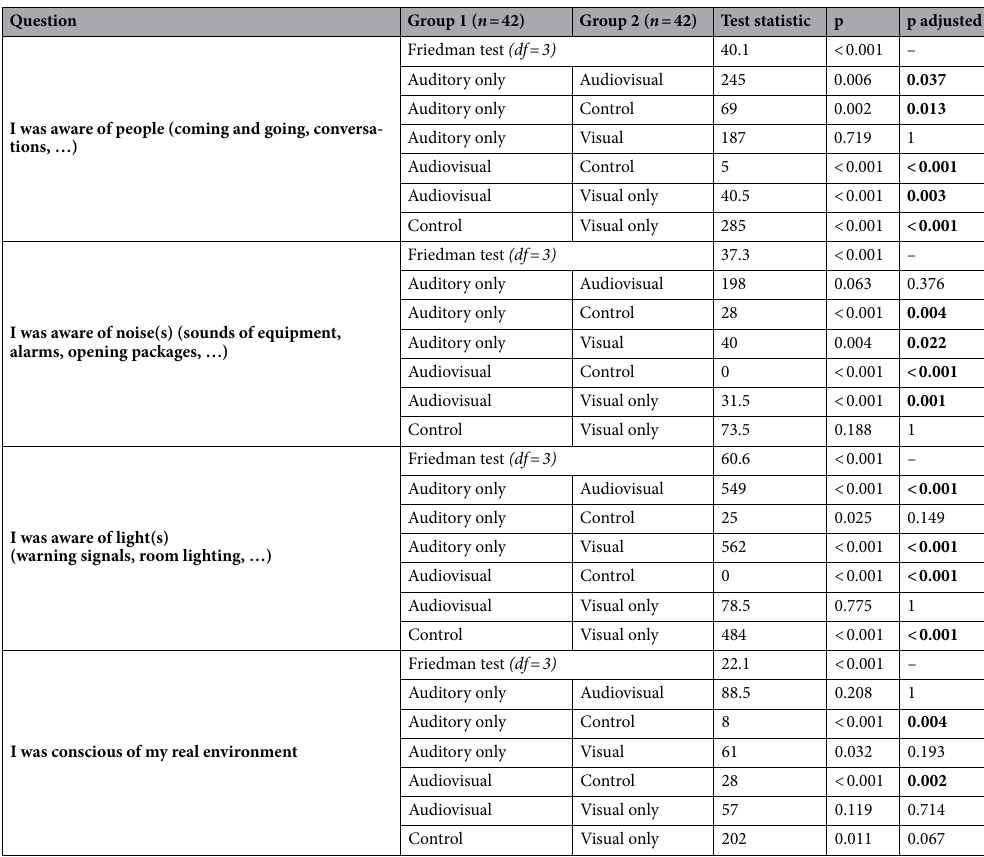
Table 4. The difference in subjective awareness between the different intervention conditions. Due to non- normality and use of an ordinal scale for the dependent variable, a non-parametric Friedman test was used. It was followed up by a pairwise Wilcoxon signed rank test, with a Bonferroni correction, to identify which conditions are different. Questions asked are presented on the left (Table 2) and were rated using a Likert scale from 1 (“Not at all”) to 5 (“Completely”). Abbreviations: Friedman test statistic (Statistic), p-value (p), Bonferroni adjusted p-value (p-adjusted). Significant p-values are in